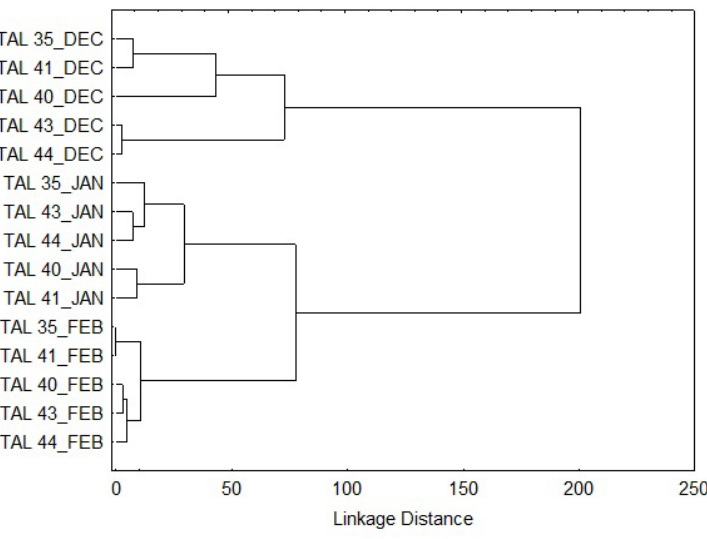
Figure 4. Dendrogram of the clustering analysis results of the different fields and evaluation periods for the scores in